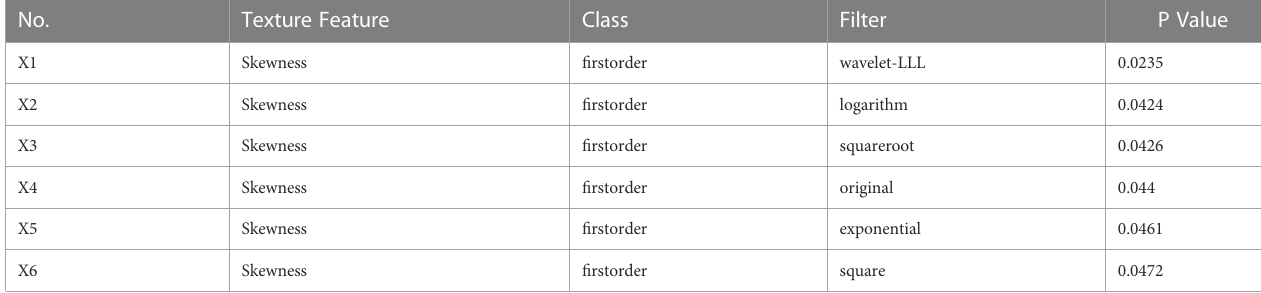
TABLE 4 Optimal texture features from the venous